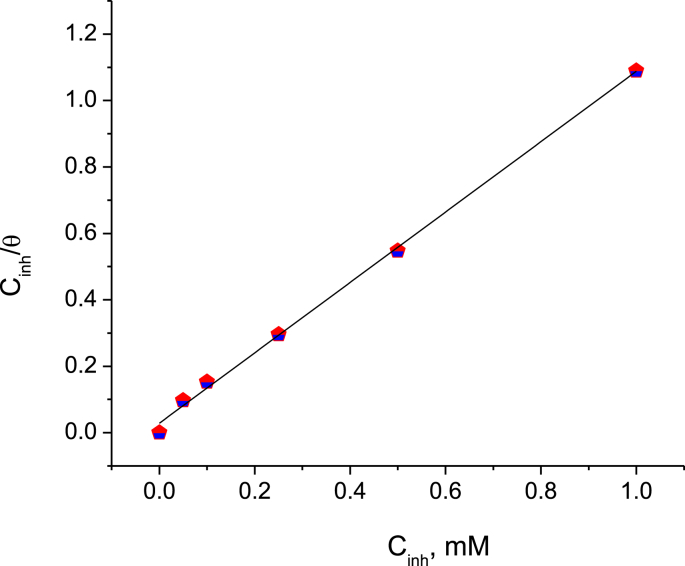
Langmuir Isotherm plot for adsorbed BQYP molecules on mild steel in 2 M H2SO4 at 298 °K.